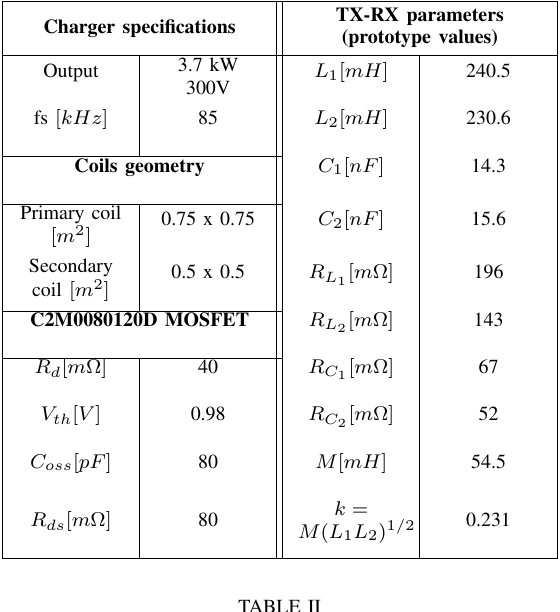
TABLE I P ARAMETERS OF THE ICPT SYSTEM .